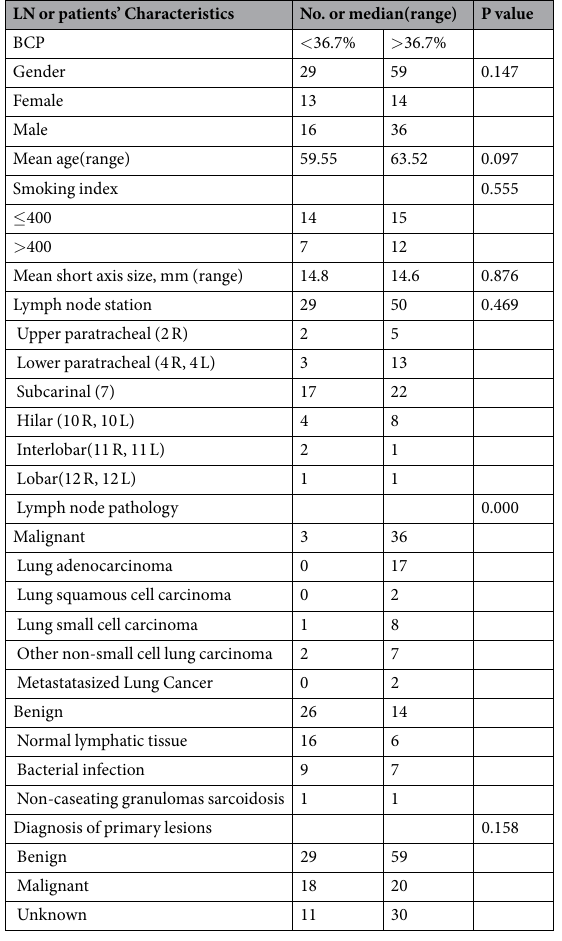
Table 1. Baseline characteristics of the patients and lymph nodes. Data are shown as number or mean (range). BCP = blue color proportion. Smoking index = average root number per day * years of